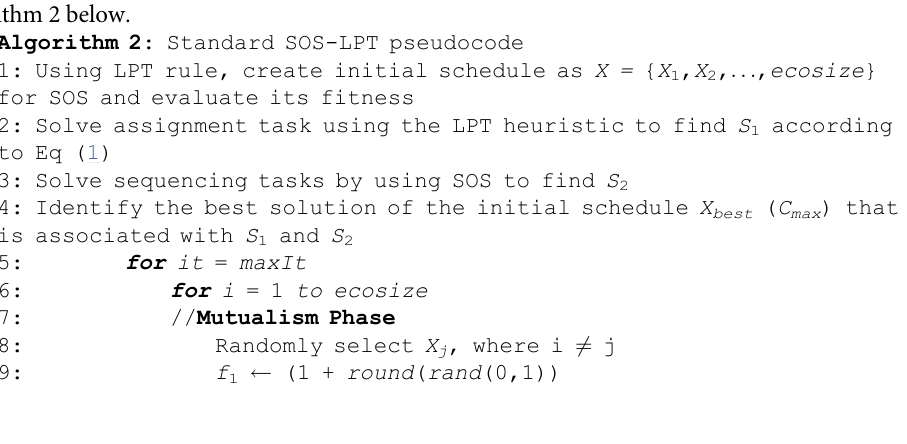
Algorithm 2 : Standard SOS-LPT